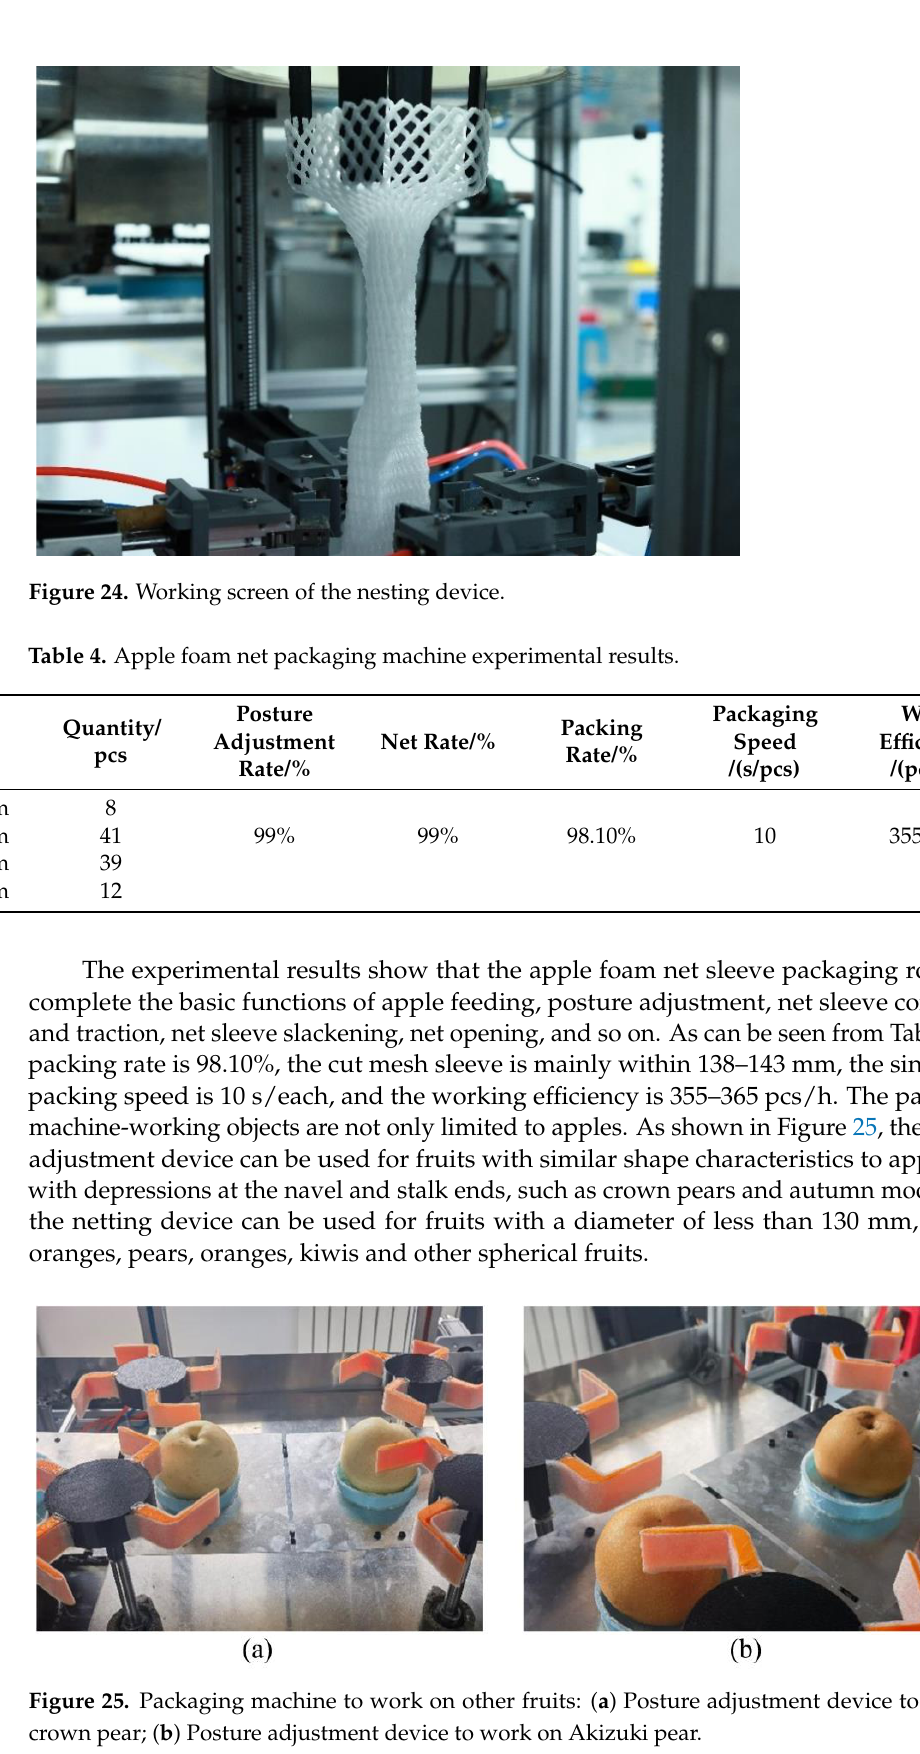
Figure 25. Packaging machine to work on other fruits: ( a ) Posture adjustment device to work on crown pear; ( b ) Posture adjustment device to work on Akizuki pear.